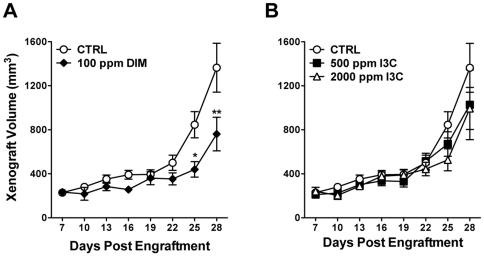
DIM and I3C suppress CEM cell xenograft growth.Male NOD.CB17-Prkdcscid/SzJ mice were engrafted with CEM cells as described in
Materials and Methods
 and fed control diet (CTRL), 100 ppm DIM (panel A) or 500 or 2000 ppm I3C (panel B) for 28 days. Growth of xenografts was assessed every third day and compared to nodule volumes in control-fed animals. *, p<0.05 or **, p<0.01 as determined by two-way repeated measures ANOVA with Bonferroni post-hoc tests to evaluate the effects of diet on tumor growth at each time point compared to the time-matched control. p-values for overall effect of each treatment on tumor growth compared to control are: 100 ppm DIM, p = 0.041; 500 ppm I3C, p = 0.356; and 2000 ppm I3C, p = 0.271.